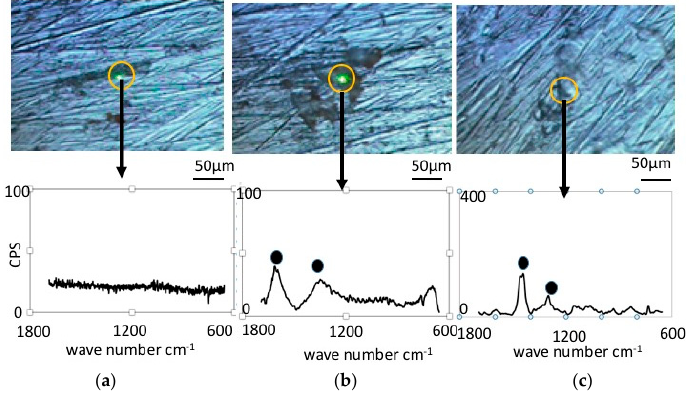
Figure 4. Raman shift peaks and the optical microscopic images for pure nickel specimens. ( a ) Before immersion; ( b ) resident microbiota; ( c ) E-coli .